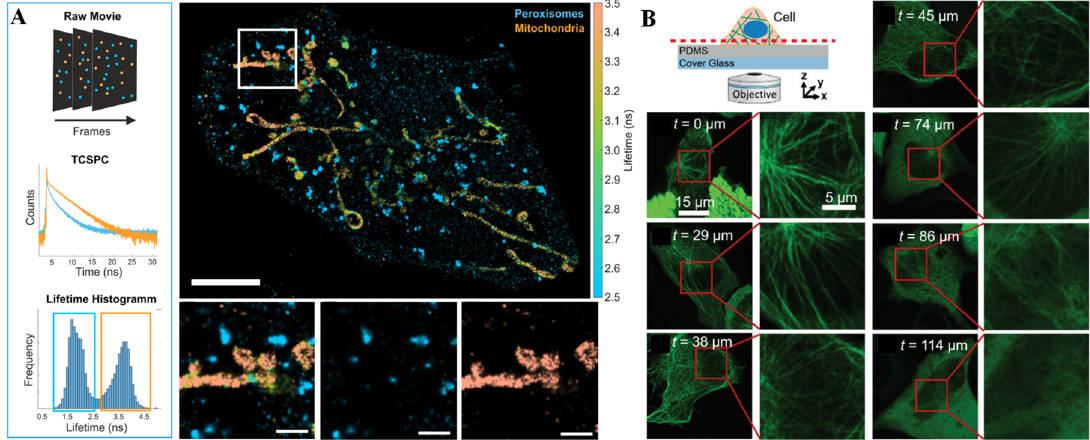
Figure 1. Fluorescence technique and applications . ( A ) Multiplexed imaging of a fixed cell in nanoscale topography by fluorescence lifetime imaging. Reprinted with permission from ref. [40], Copyright 2022 Springer Nature. ( B ) Overview of the sensing device and example images of fluo- rescent microtubules obtained through laser scanning microscopy on a PDMS layer with various thicknesses. Reprinted with permission from ref. [43], Copyright 2020, Royal Society of Chemistry.